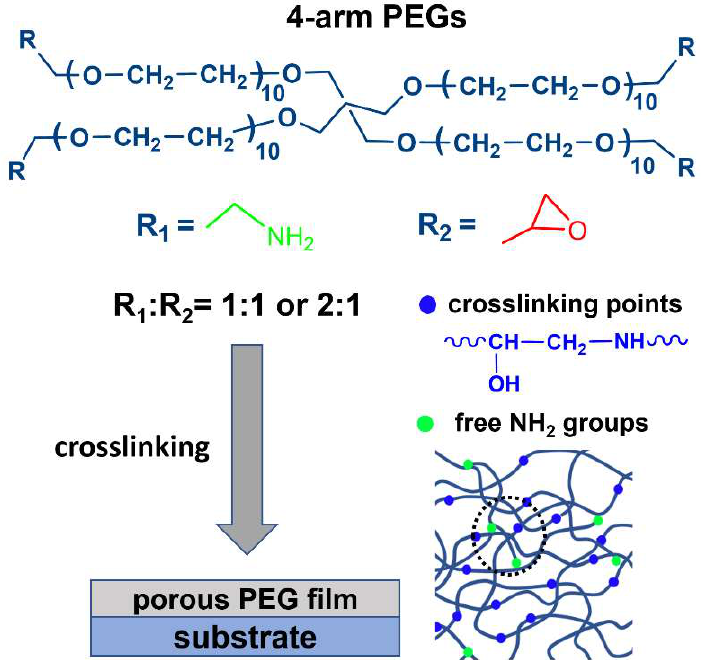
Figure 1. Structure of the STAR-NH 2 (R 1 ) and STAR-EPX (R 2 ) precursors and a schematic drawing of the PEG film fabrication procedure relying on the extensive crosslinking of the precursors, mediated by the reactions between their terminal amine (R 1 ) and epoxy (R 2 ) groups. The resulting crosslinking points (ethanol-amine bridges) are marked by blue circles in the porous PEG film scheme (bottom, right); free (non-reacted) NH 2 groups are depicted as green circles. The mixing ratio of the precursors was varied.